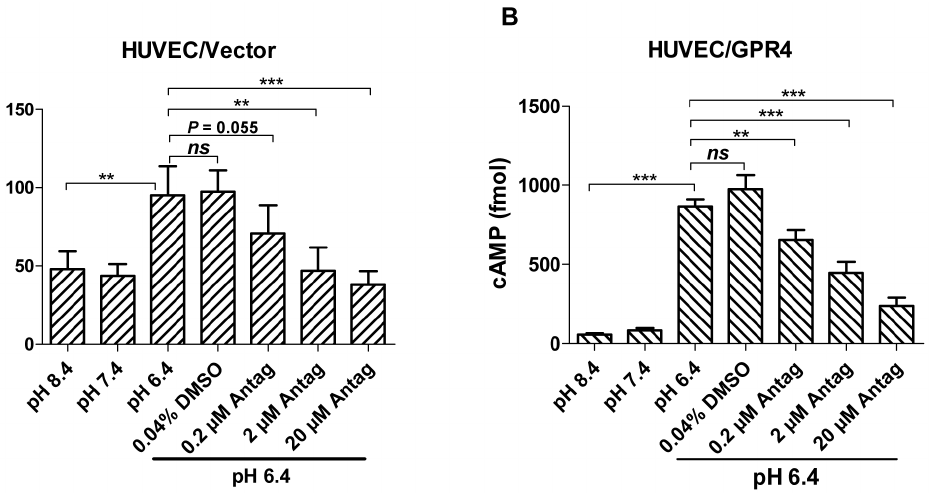
Figure 8. Inhibition of acidosis/GPR4-induced cAMP production by the GPR4 antagonist in HUVEC. (A–B) HUVEC/Vector and HUVEC/ GPR4 cells were treated with varying pH in the presence or absence of the GPR4 antagonist EIDIP. After the pH treatment, intracellular cAMP was measured as described in the Materials and Methods. The vehicle control had 0.04% DMSO which is the same DMSO concentration as that in 20 m M GPR4 antagonist. The results are the average of 10 samples for HUVEC/Vector cells and 7 samples for HUVEC/GPR4 cells. Error bars indicate the mean 6 SEM. **, P , 0.01; ***, P , 0.001; ns , not significant.